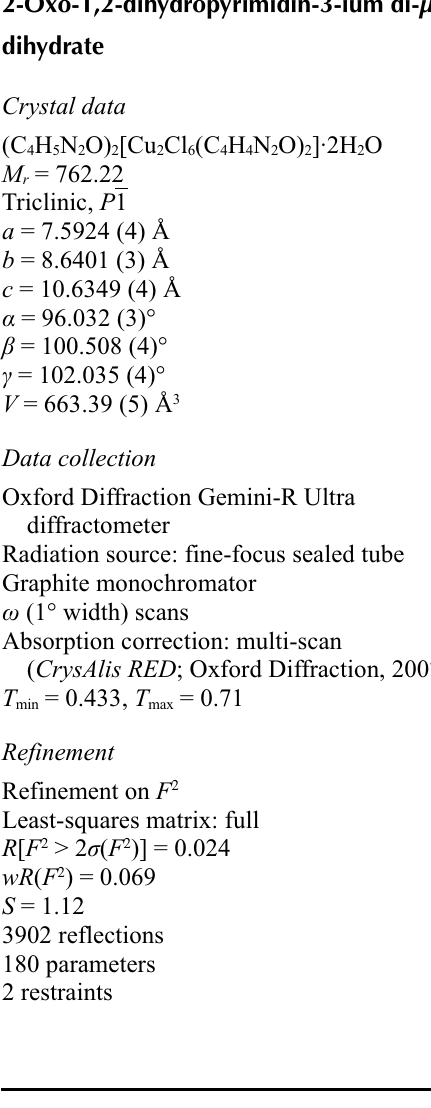
Packing of I in the ac plane, with O—H···Cl bridges between the water molecules and the dianions, N—H···O hydrogen bonds between cations and water molecules, and N—H···Cl hydrogen bonds between the anions and